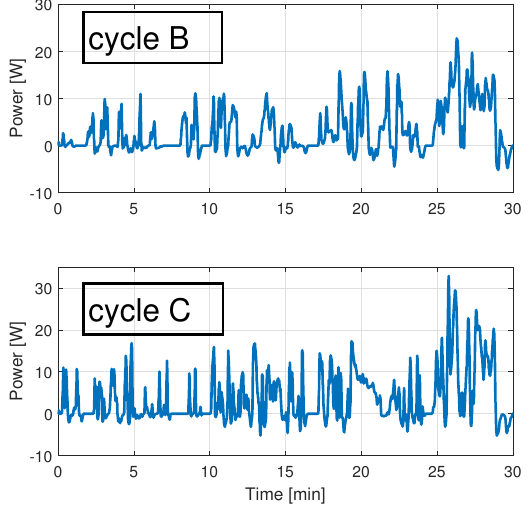
Figure 7. Validation power profile: Power Cycle B, top and Power Cycle C, bottom . Figure 8 shows the performance of the EKF, with the proposed genetically optimized covariance matrix, in estimating the cell voltage, performed on a new LG cell using cycle “A”. Figure 9 shows the result obtained on a different cell at the end of its life, performed on cycle “C”.